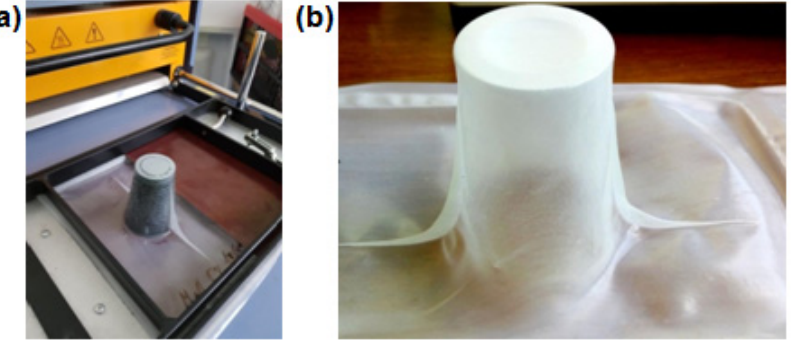
Figure 1. The thermoformed cup placed on a plug assist after the thermoforming operation ( a ) and webbing effect of the thermoformed cup ( b ).